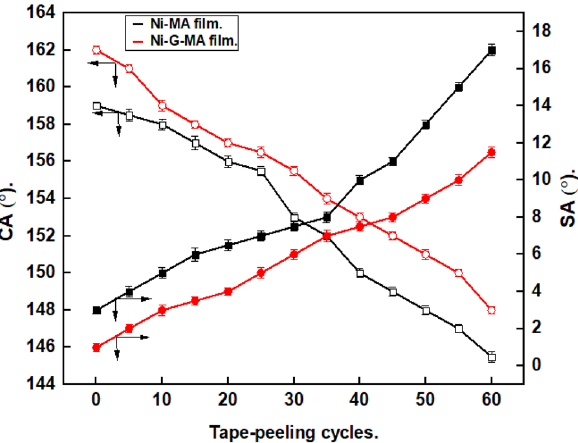
Figure 5. Effect of cyclic tape peeling on the CAs and SAs of copper grafted by Ni-MA film and Ni-G-MA film.